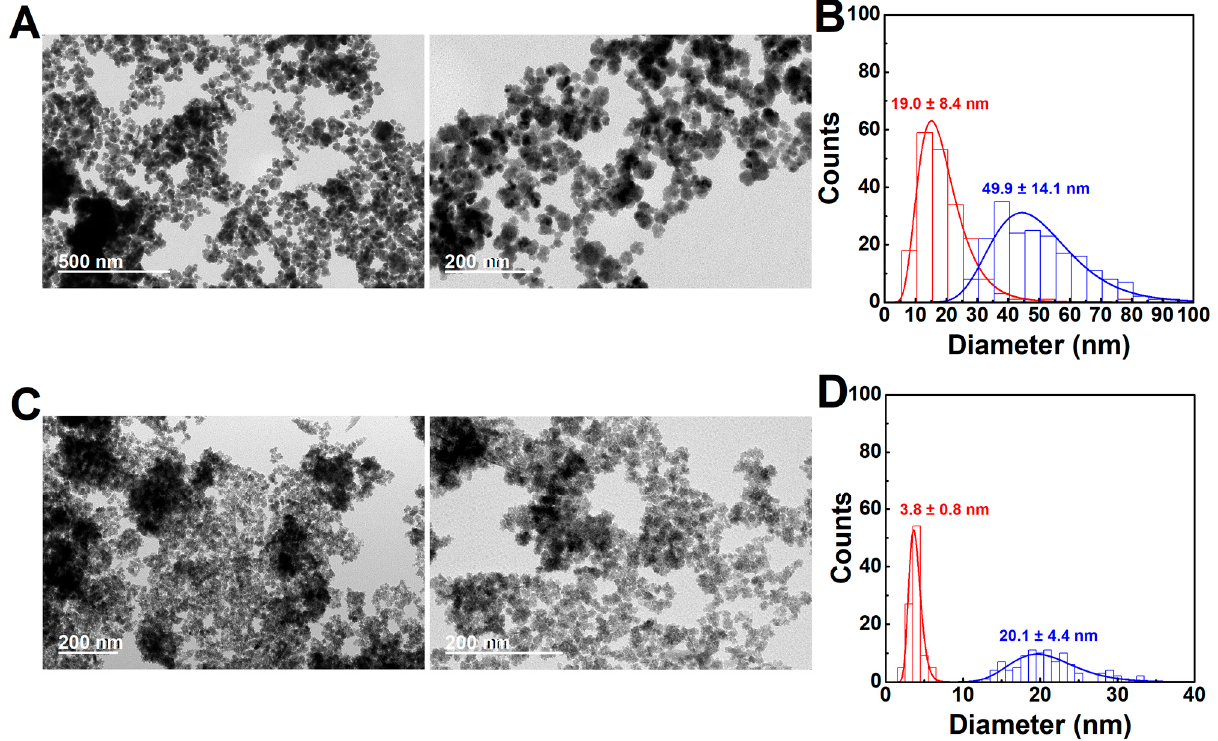
Figure 2. TEM images and histograms of the particles obtained from the synthesis of ( A , B ) manganese and ( C , D ) calcium ferrites at 100 °C, in the presence of citric acid. The red histogram corresponds to the smaller single cores forming part of the multicore-like particles (blue histogram).